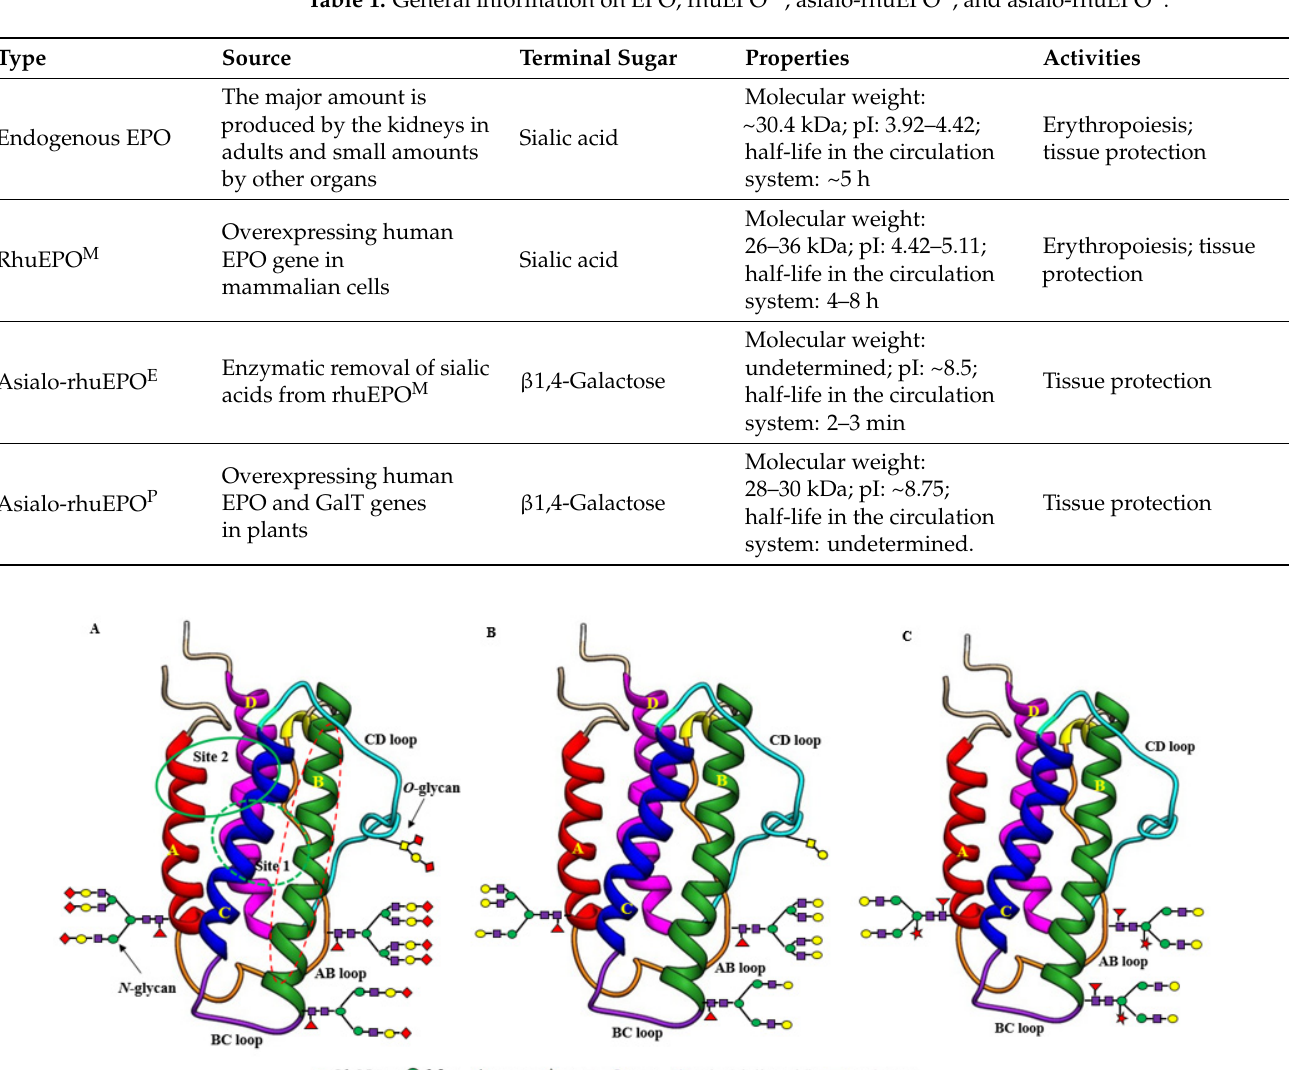
Table 1. General information on EPO, rhuEPO M , asialo-rhuEPO E , and asialo-rhuEPO P .